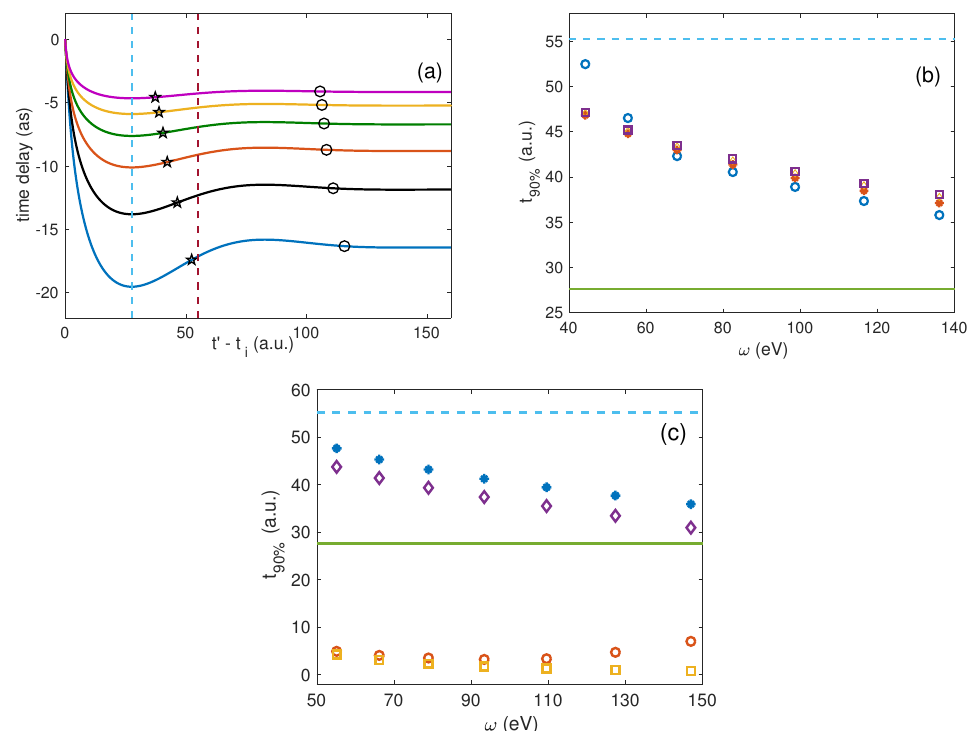
Figure 5. ( a ) Analytical predictions for the streaking time delay (in attoseconds) of hydrogen atom as a function of time t (cid:48) − t i (in atomic units) for electron kinetic energies corresponding to XUV central frequencies of ω = 44.22 eV (blue), ω = 55.27 eV (black), ω = 68.03 eV (red), ω = 82.48 eV (green), ω = 98.64 eV (yellow), and ω = 116.49 eV (pink) and a three-cycle streaking pulse. The times t 90% and t 99% are shown as stars and circles, respectively, and T /4 and T /2 are denoted with dashed vertical lines; ( b ) time t 90% (in atomic units) is shown as a function of XUV central frequency for different streaking pulse durations; N s = 3 cycles (circles), N s = 4 cycles (stars), N s = 5 cycles (diamonds), and N s = 6 cycles (squares). Further shown is T /2 (dashed light blue) and T /4 (solid green); ( c ) same as panel (b) but for helium atom and the separate contributions, short-range (circles), Coulomb-phase (squares), logarithmic (diamonds), and the total (stars) in a three-cycle streaking pulse. For all calculations, a streaking pulse of wavelength λ s = 800 nm and I s = 1 × 10 12 W/cm 2 has been